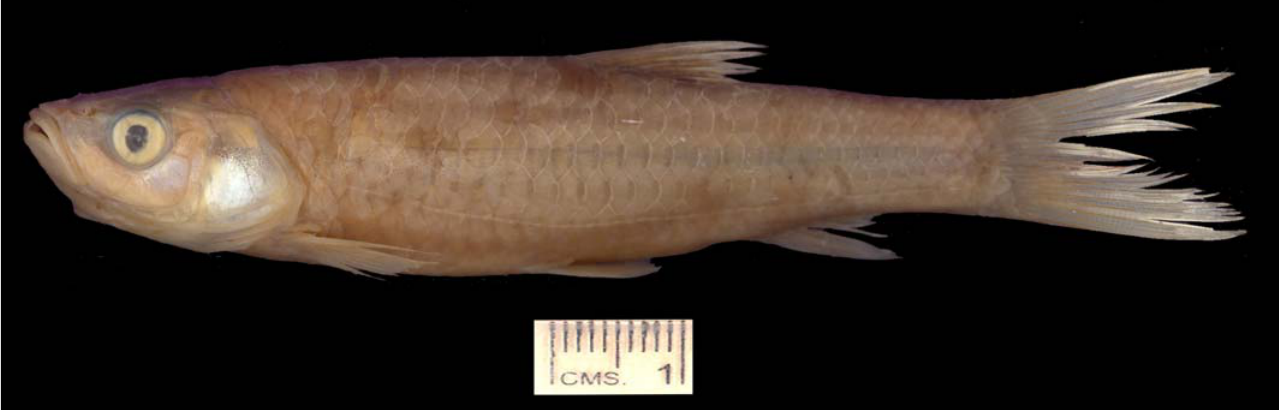
Table 1. Ichthyofaunal collections from Solapur District at the Zoological Survey of India, Pune collections Order: Osteoglossiformes Family: Notopteridae Notopterus notopterus (Pallas) Order: Cypriniformes Family: Cyprinidae Subfamily: Cyprininae Osteobrama cotio cotio (Ham-Buch) Osteobrama neilli (Day) Osteobrama cotio peninsularis Silas Puntius conchonius (Ham-Buch) Puntius chola (Ham-Buch) Puntius sophore (Ham-Buch) Puntius ticto (Ham-Buch) Hypselobarbus kolus (Ham-Buch) Puntius sarana subnasutus (Val.) Puntius sarana sarana (Ham-Buch) Cirrhinus fulungee (Sykes) Cirrihinus mrigala (Ham-Buch) Subfamily: Cultrinae Chela cachius (Ham-Buch) Chela laubuca (Ham-Buch) Salmostoma boopis (Day) Salmostoma acinaces (Val.) Salmostoma untrahi (Day) Salmostoma phulo (Ham-Buch)